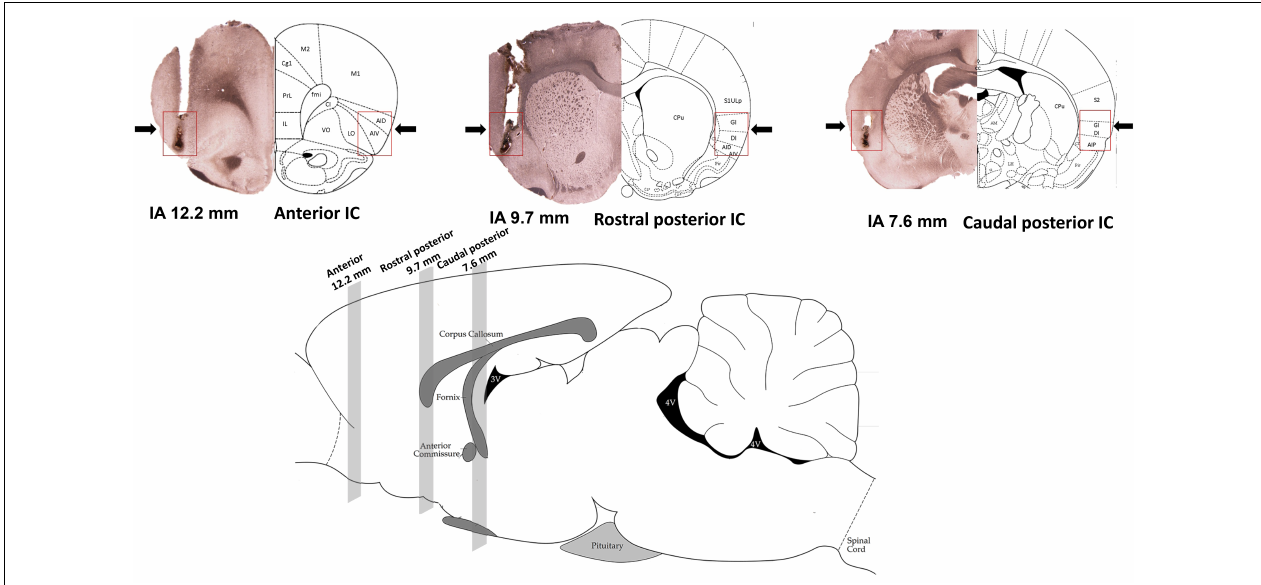
FIGURE 1 | Location of the subregions along the rostrocaudal axis of the insular cortex (IC). (Top) Photomicrograph of coronal brain sections depicting the microinjection sites of representative animals (left hemisphere) and diagrammatic representations modified from the rat brain atlas of Paxinos and Watson (1997) (right hemisphere) indicating the anterior [interaural (IA) 12.7 mm], rostral posterior (IA 9.7 mm), and caudal posterior (IA 7.6 mm) subregions of the IC. Arrows and red squares indicate the microinjection site and IC region. (Bottom) Representation of a sagittal section of the rat brain modified from the rat brain atlas of Paxinos and Watson (1997) indicating the position of the anterior (12.7 mm), rostral posterior (9.7 mm), and caudal posterior (7.6 mm) subregions of the IC along the rat brain. The numbers indicate the IA distance.